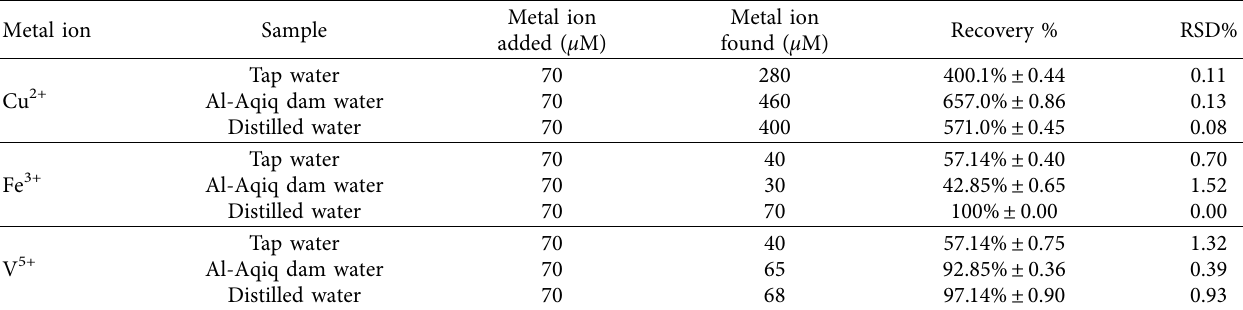
Figure 10: (a, b) Interference studies for the selectivity of the chemosensor SL towards V 5+ (70 μ M) in the coexistence of other cationic species (70 μ M). Table 2: Analytical results for real water sample